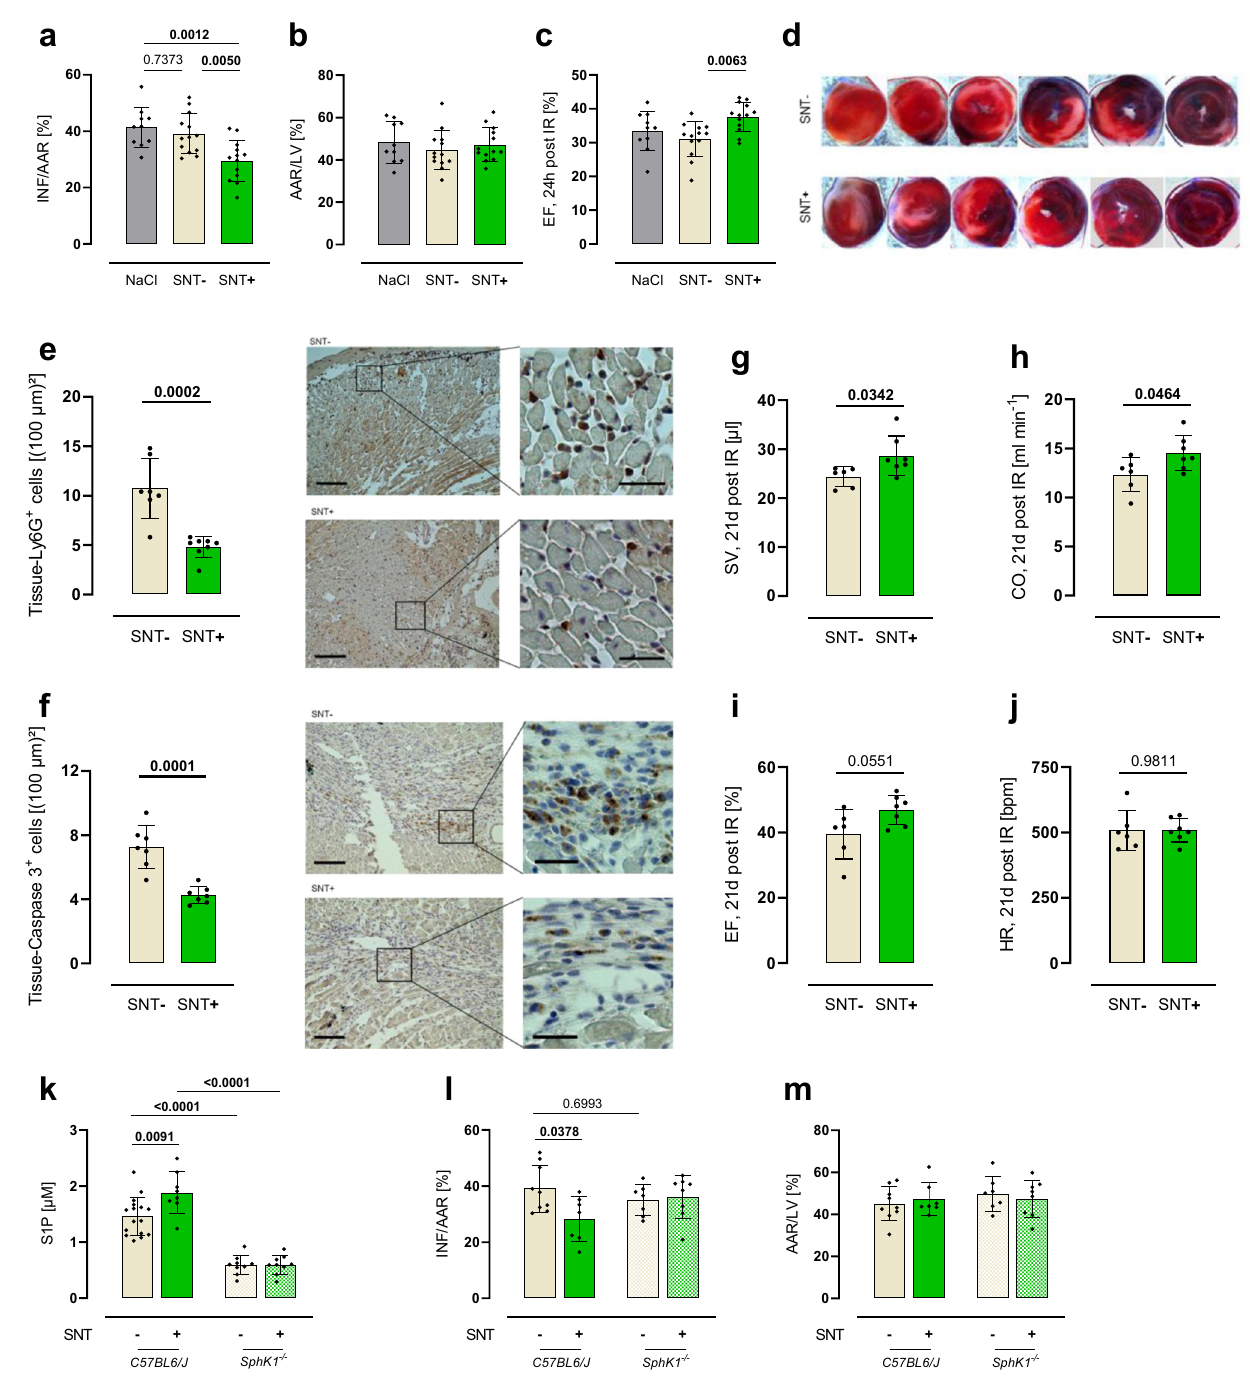
Fig. 1 | Supernatant of activated platelets reduces infarct size and improves cardiac outcome after myocardial infarction — this depends on platelet sphin- gosine kinase 1. a Injection of cell-free supernatant of activated platelets (SNT+) prior AMI leads to decreased infarct size (INF/AAR) after 24h of reperfusion as compared to supernatant of non-activated platelets (SNT − ) and NaCl (ANOVA- analysis, n NaCl =10, n SNT − =13, n SNT+ =13). b Area at risk per left ventricle (AAR/LV) did not differ between the groups. c Echocardiographic assessment 24h post AMI showed improved cardiac function (EF = ejection fraction) in SNT+ treated mice (ANOVA-analysis, n NaCl =10, n SNT − =13, n SNT+ =13). d Exemplary images of TTC- stainedhearts. e ThisreductionofinfarctsizebySNT+wasassociatedwithreduced neutrophil accumulation 24h after AMI (unpaired t test, n SNT − =7, n SNT+ =8,